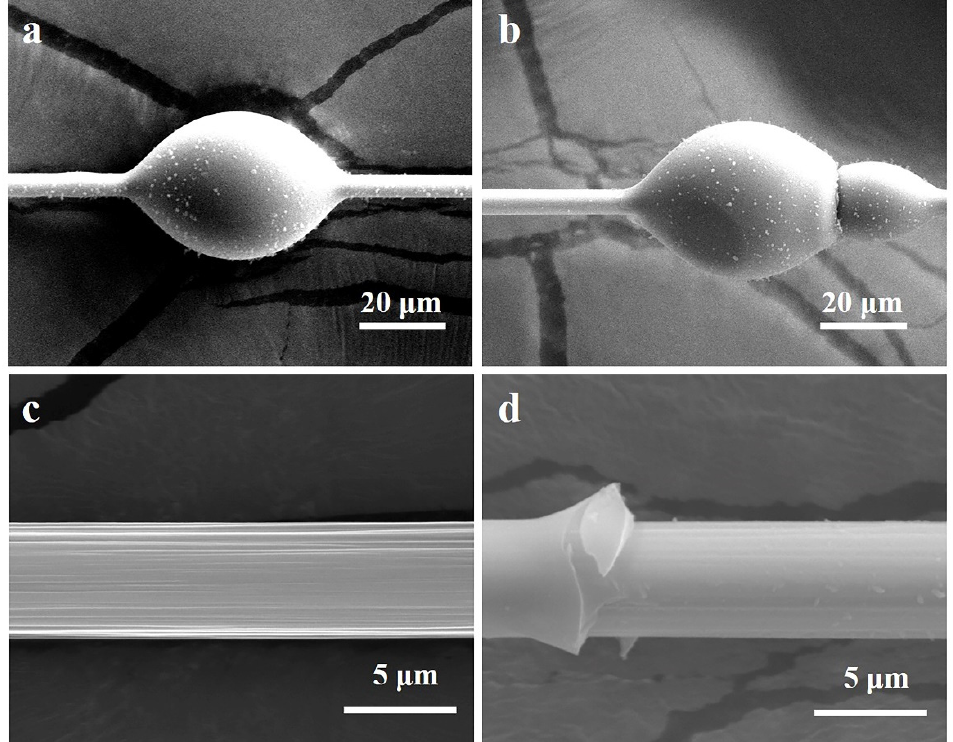
Figure 11. Micro-droplet debonding test sample image of: ( a ) before fracture, ( b ) after fracture, ( c ) CF surface morphology, ( d ) fracture morphology of CF/EP composite.